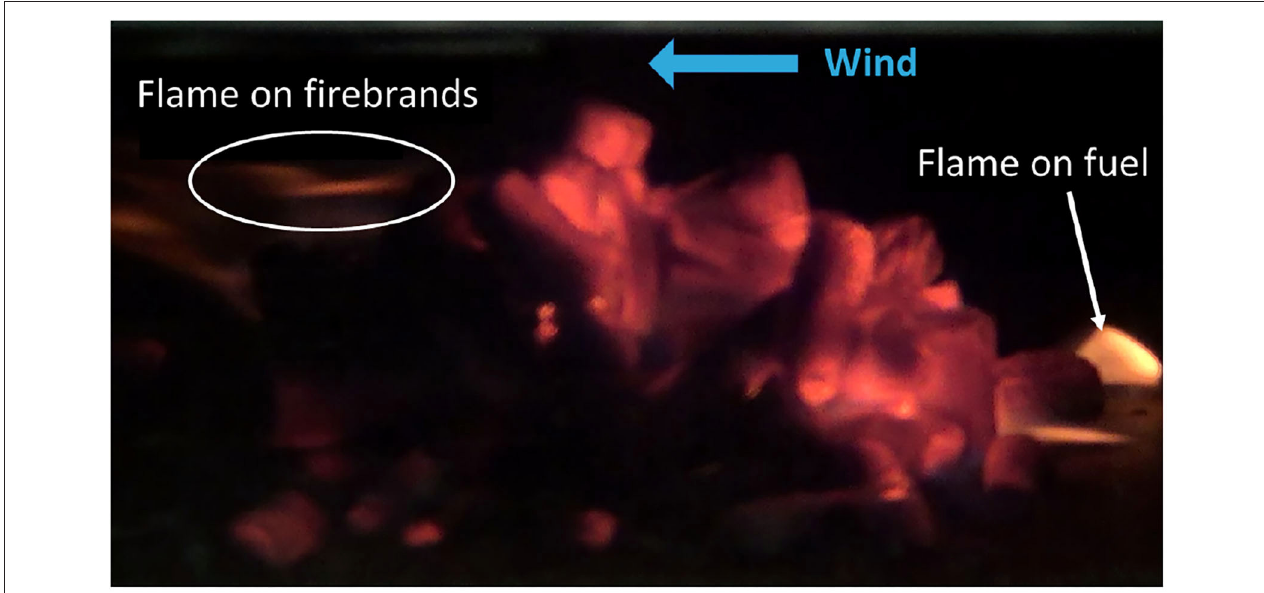
FIGURE 8 | Photograph showing flames present both over the pile of firebrands, downwind and attached to the glowing firebrands, and over the fuel surface, upwind and anchored to the fuel surface.